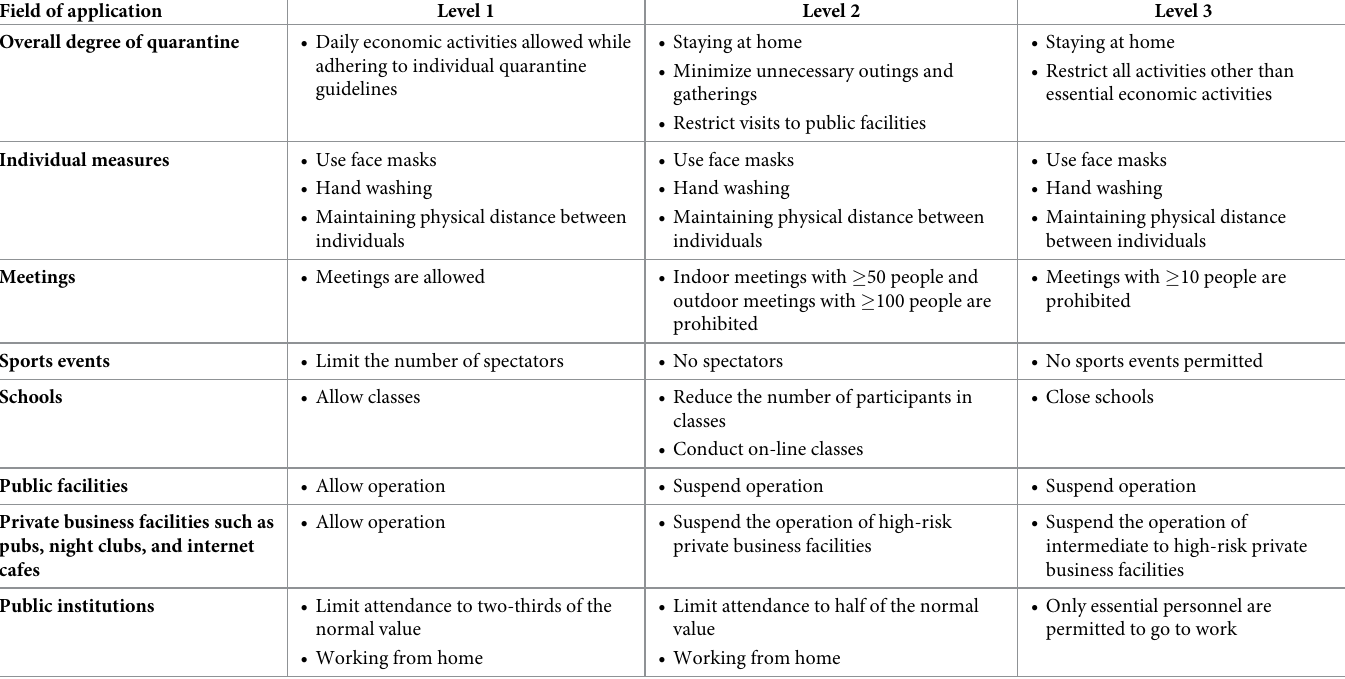
Table 1. Level of social distancing in South